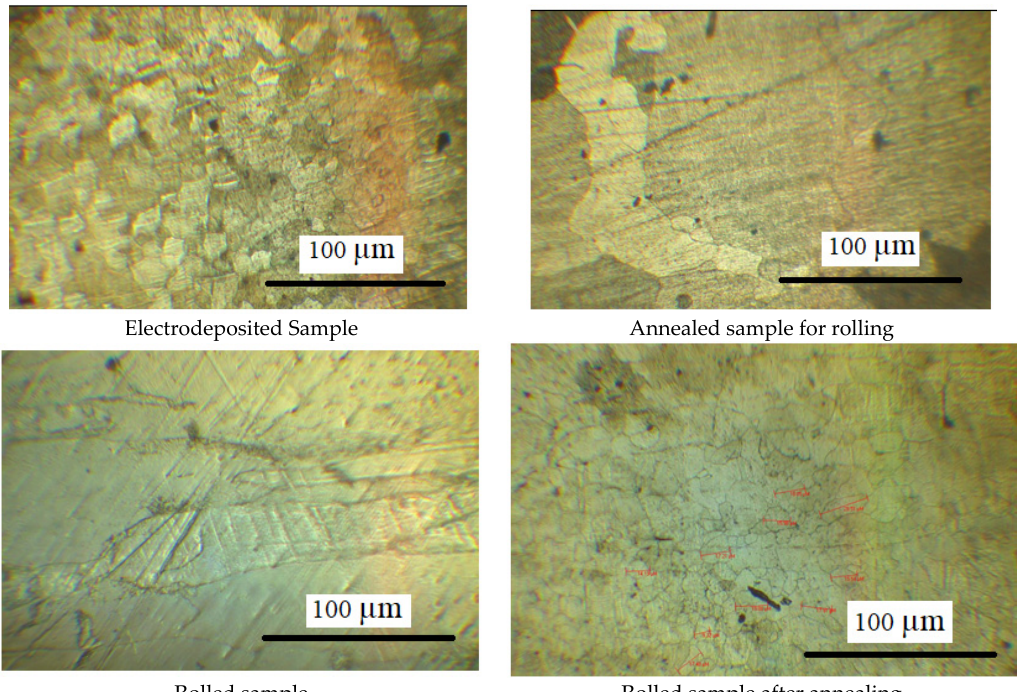
Figure 8. Microstructure of pure iron during various phases of manufacturing.